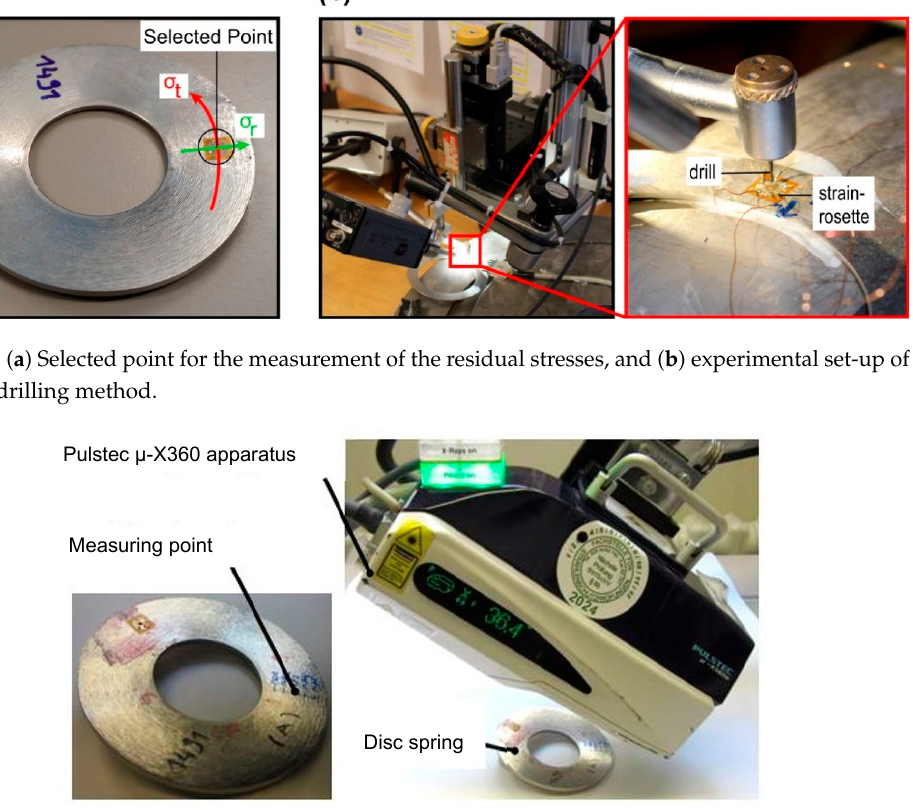
Figure 3. ( a ) Selected point for the measurement of the residual stresses, and ( b ) experimental set-up of the hole drilling method.